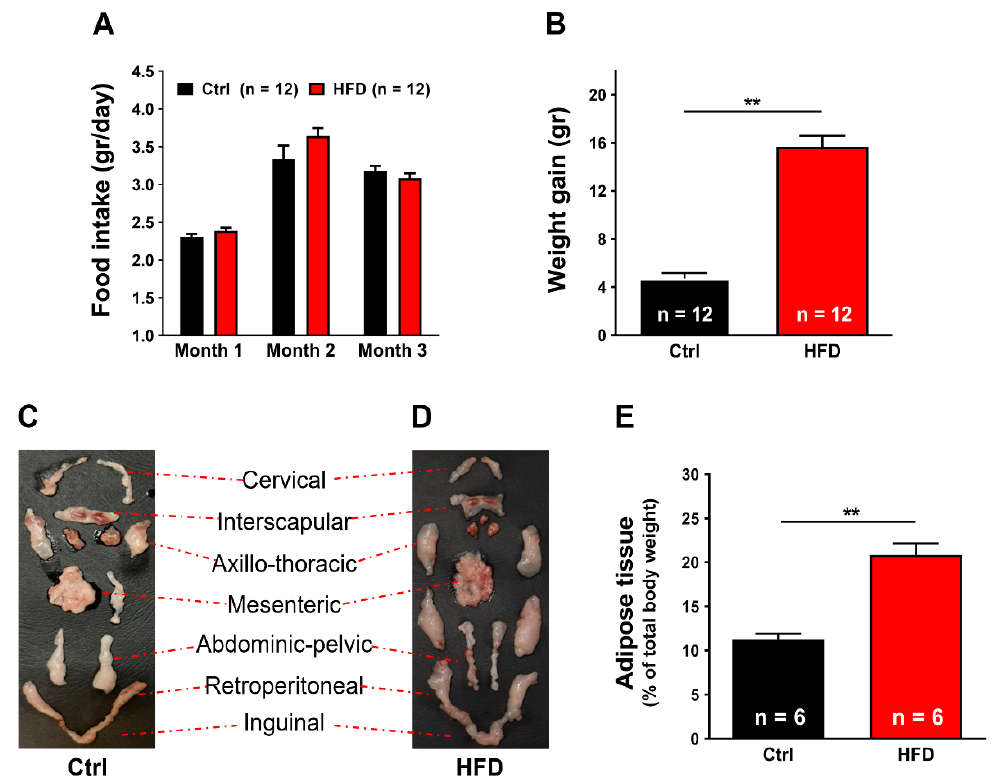
Figure 1. Food intake, weight gain, and body fat mass. ( A ) Food intake during the 3 months of HFD treatment (1–4 months of age). ( B ) Weight gain during the 3 months of HFD treatment. ( C , D ) Representative dissection of the total adipose tissue, from Ctrl ( D ) vs. HFD ( D ) mice. ( E ) Amount of adipose tissue expressed as percentage of total body weight. Data are shown as mean ± SEM (** p < 0.01, as evaluated by two-tailed unpaired Student’s t -test). n = number of mice tested.